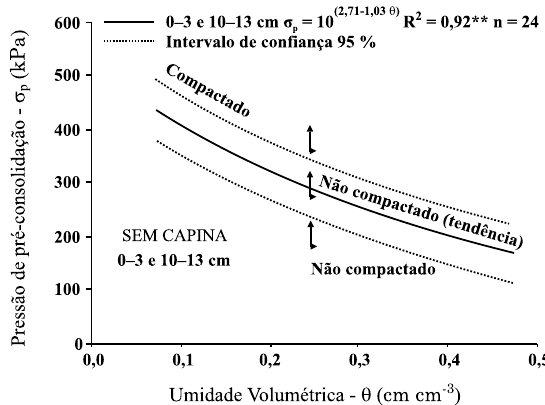
Figura 2. Modelo de capacidade de suporte de